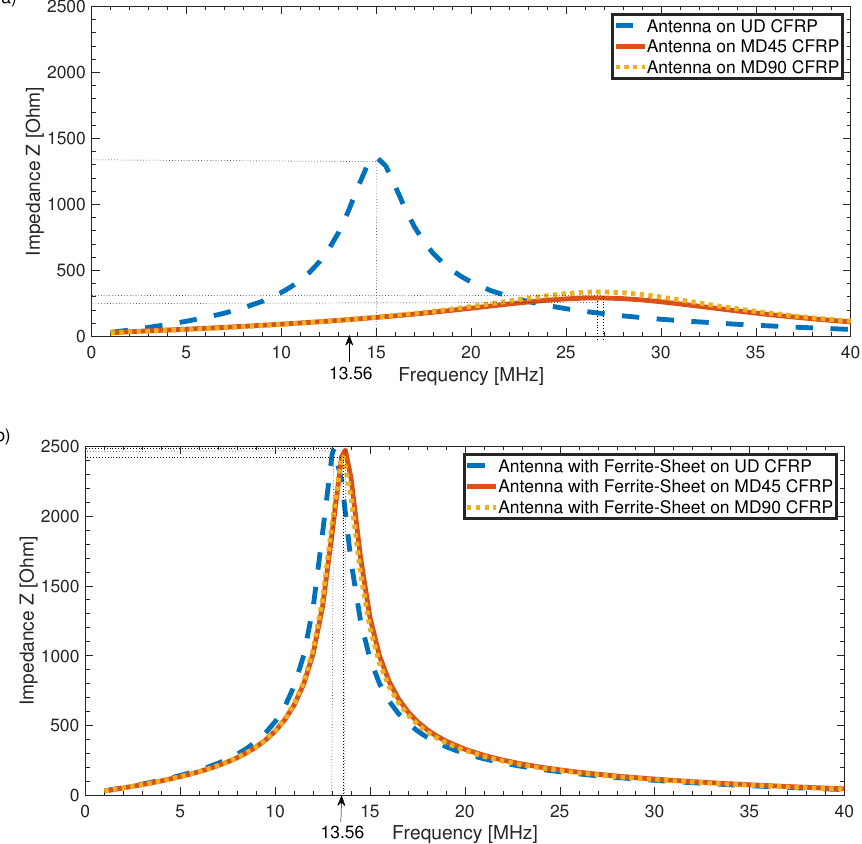
Figure 10. ( a ) Frequency shift for different CFRP configurations as substrate. ( b ) Resonance frequency for antennas on ferrite sheet on different CFRP configurations as